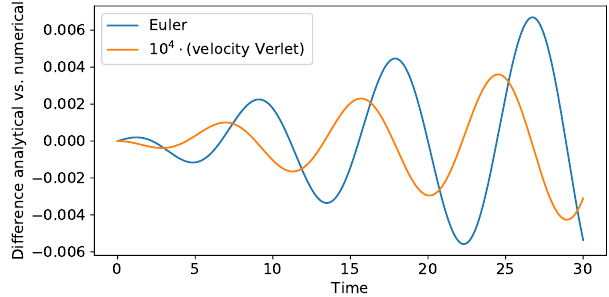
Fig. 105.— Difference between our numerical solution and the analytical solution, once for the Euler algorithm, once for the ve- locity Verlet algorithm (the latter here scaled up artificially by a factor 10 4 )